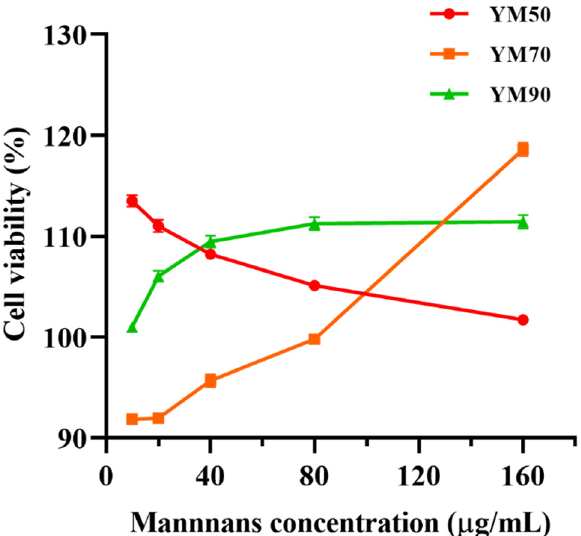
Figure 5. Cytotoxicity of mannans from on Caco-2 cells by MTT method. Data are mean ± SD ( n =